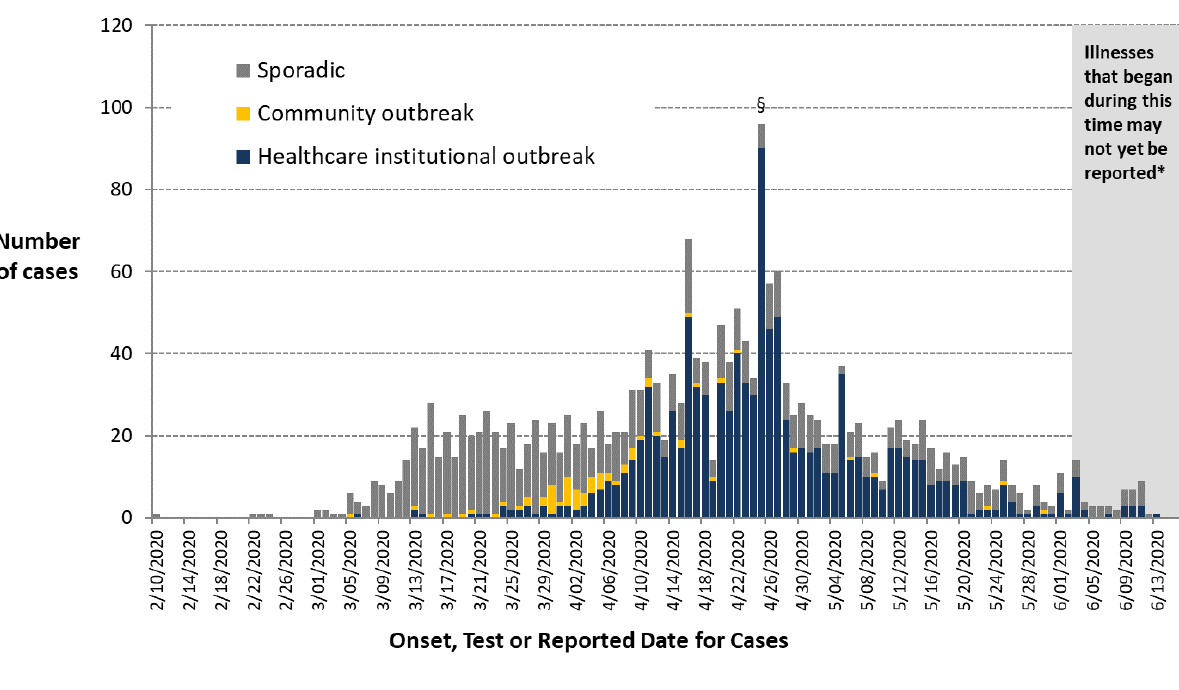
Figure 3. Epidemiological curve of Ottawa residents with confirmed COVID-19, by the EARLIEST of onset, test and reported date, by outbreak association †